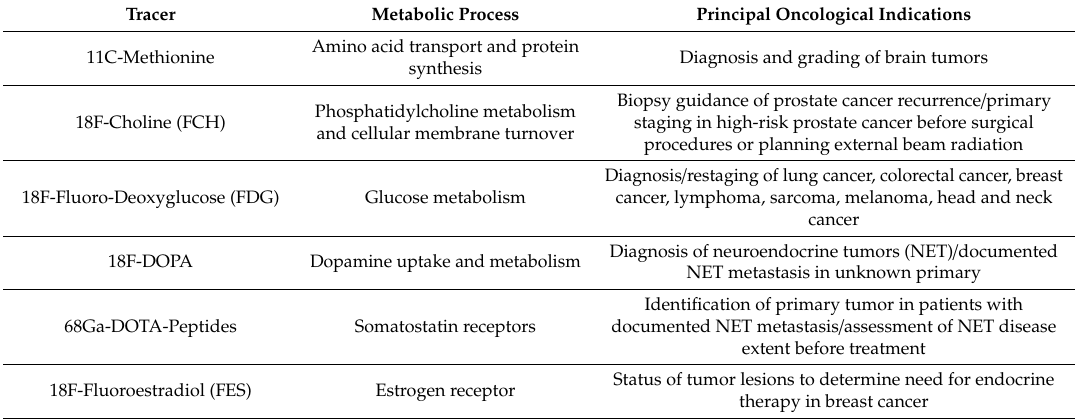
Table 1. Main validated positron-emission-tomography (PET) tracers and their principal indications (based on